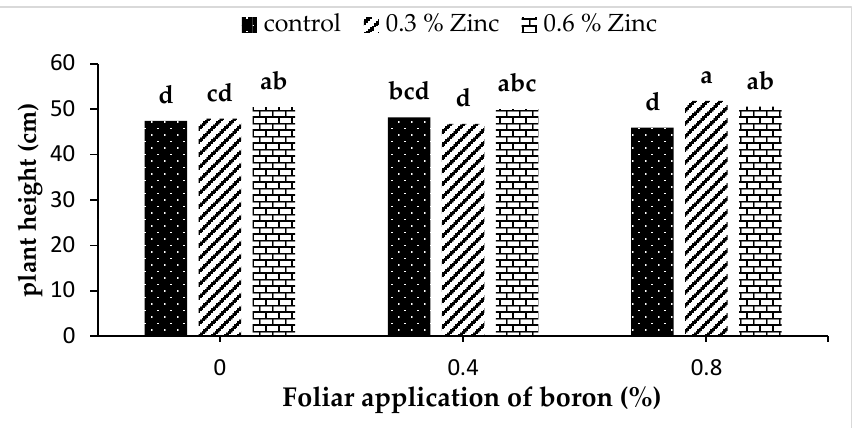
Figure 1. Interaction effect of zinc and boron foliar application on plant height of S. khuzistanica in the first year. Means with the same lower-case letter are not significantly different at p < 0.05 according to the LSD test.